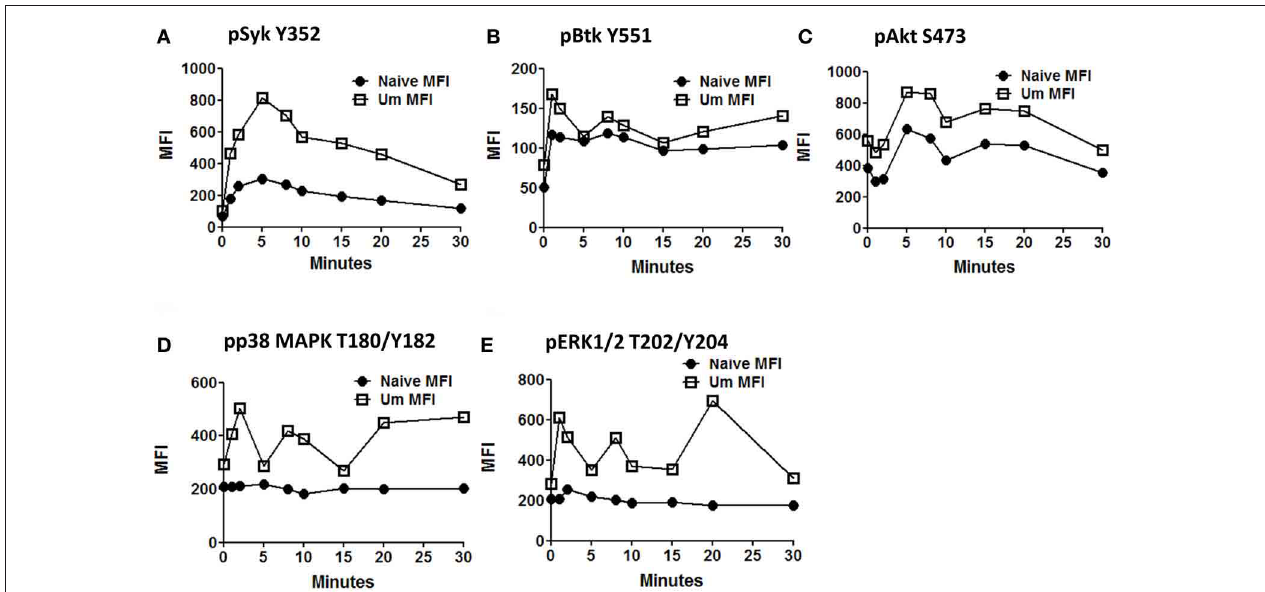
FIGURE 5 | Time course of signaling proteins and pathways associated with the BCR in naïve and Um B cells. Two multicolor panels were used to explore simultaneous phosphorylation of signaling proteins and pathways associated with the BCR at various time points. The data shown is from one representative volunteer and is presented as mean fluorescence intensity (MFI). Um demonstrated enhanced phosphorylation potential for all the phosphoproteinsassayed compared to naïve B cells ( A to E ) following anti-IgM stimulation. Interestingly, Um and naïve B cells demonstrated